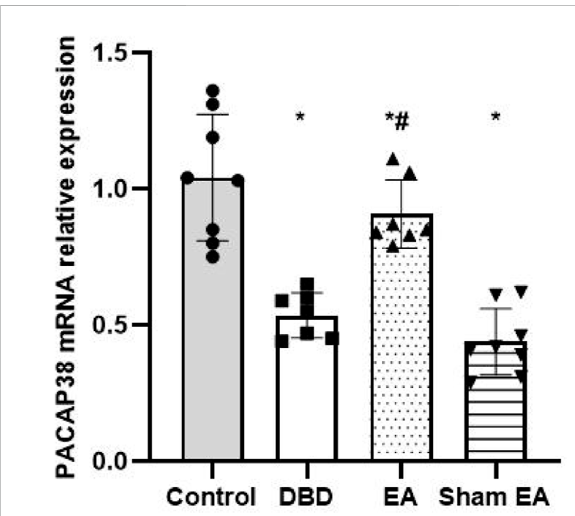
FIGURE 8 The effect of EAon PACAP38 mRNA inthe rat bladder measured by real-time PCR. The relative expression of PACAP38 mRNA among groups. Control: n = 8 rats, DBD: n = 7 rats, EA: n = 7 rats, Sham EA: n = 8 rats. The Results are expressed as mean ± standard error of the mean. * p < 0.01 versus the Control group. # p < 0.01 versus the Sham EA group (one-way ANOVA).